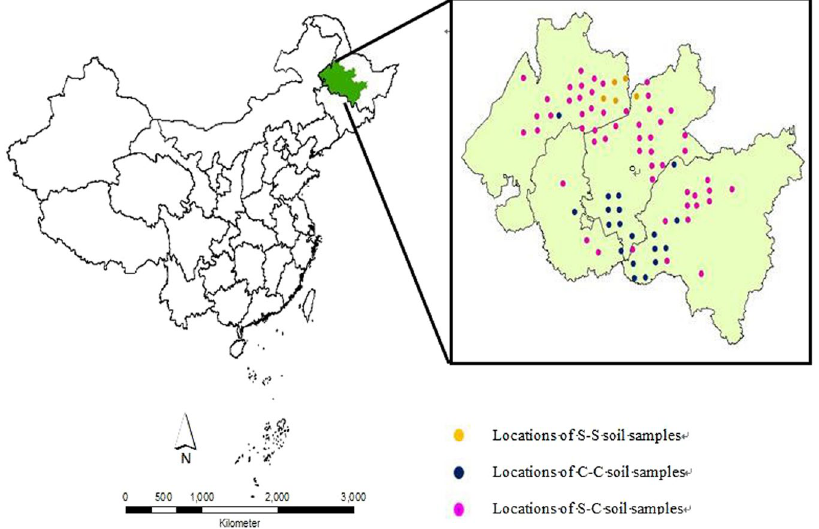
Figure 4. The locations of sampling sites in Heilongjiang Province, China. Blue circles indicate corn monocropping during 2005–2014 (C-C), yellow circles indicate soybean monocropping during 2005–2014 (S-S), pink circles indicate break crop during 2005–2014 (S-C). Samples for C-C, S-S and S-C were 20, 5 and 55 respectively. The map created by the ArcGIS 10.2 software package.